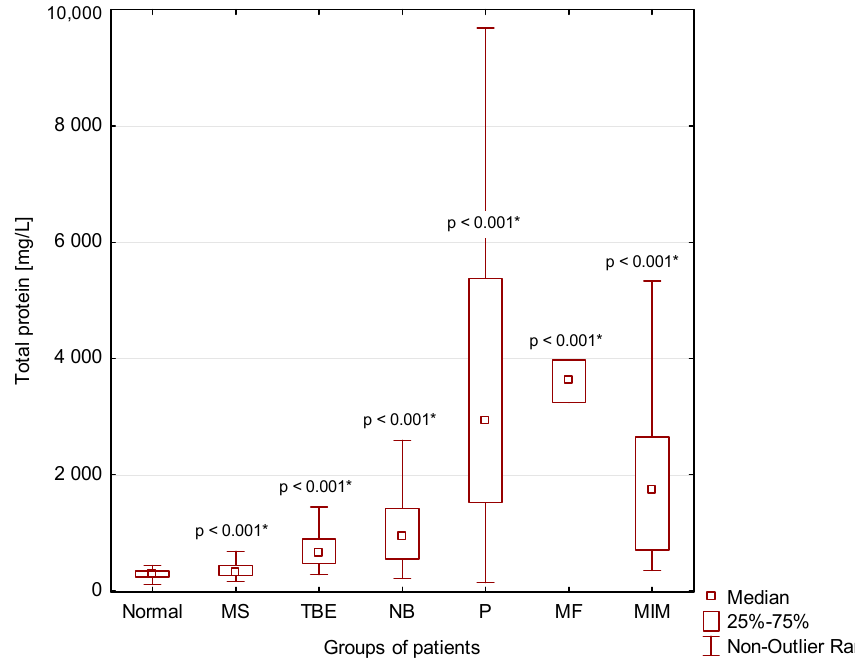
Figure 2. CSF total protein concentrations in our patient groups (*: statistically significant).